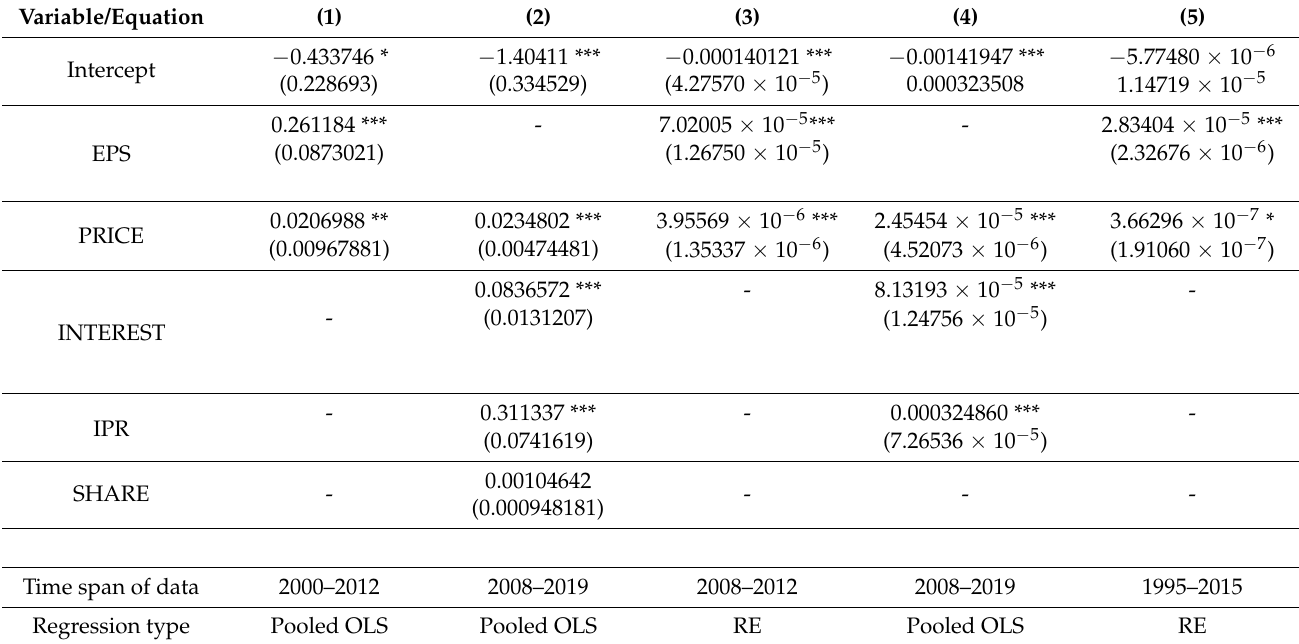
Table 4. Regression